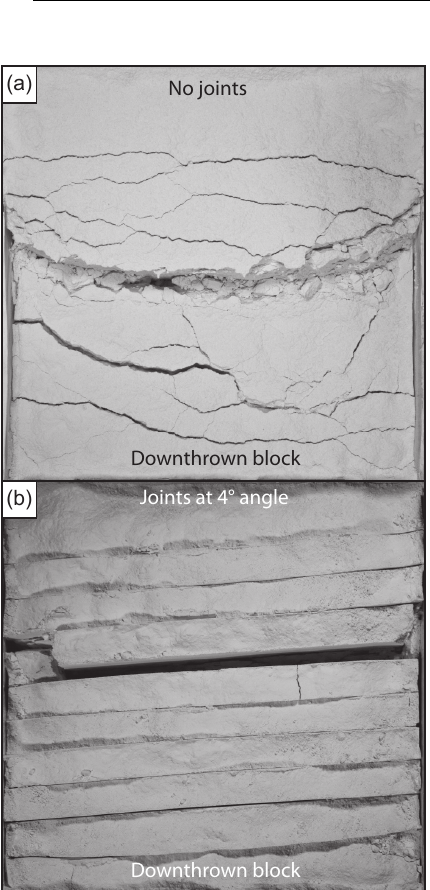
Figure 4. (a) Top-view photo of an experiment without pre-existing joints. Note the rather rugged shape of the mater fault and the minor fractures. (b) Top-view photograph of the experiment with a 4 ◦ JF- angle. All deformation localizes at the pre-existing